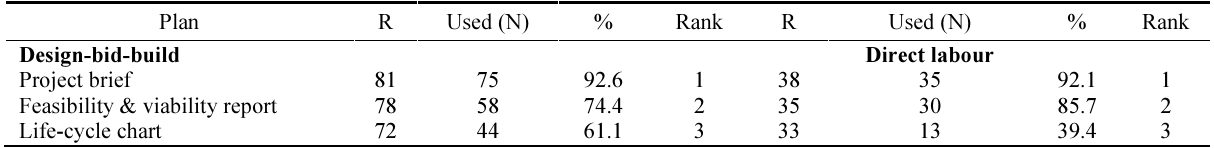
R = Number of respondents, N = Number of projects in which plan is prepared, % = Percentage of N to